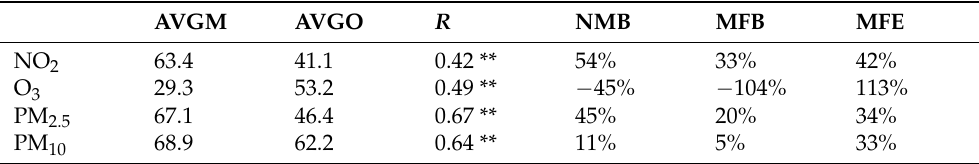
Table 5. Statistical analysis of simulated and observed hourly near-surface NO 2 , O 3 , PM 2.5 , PM 10